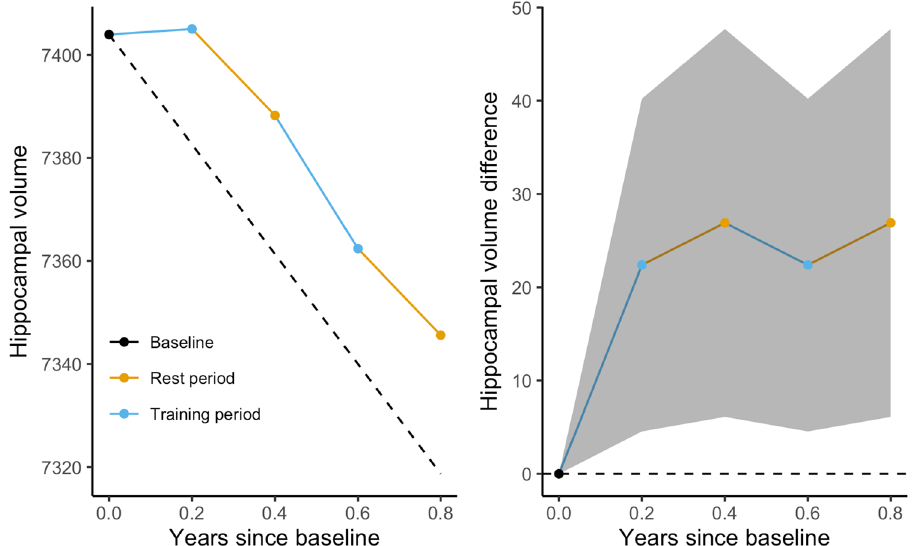
Figure 4. Estimated short-term effect of the training in the older group. The dashed line represents the reference condition of no training. The right parts of the plots show the estimated difference between the curves, with 95% confidence intervals for the difference.